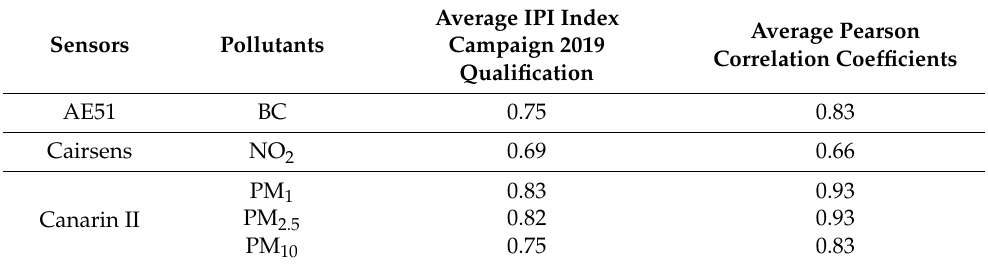
Table 1. Average IPI indices of the